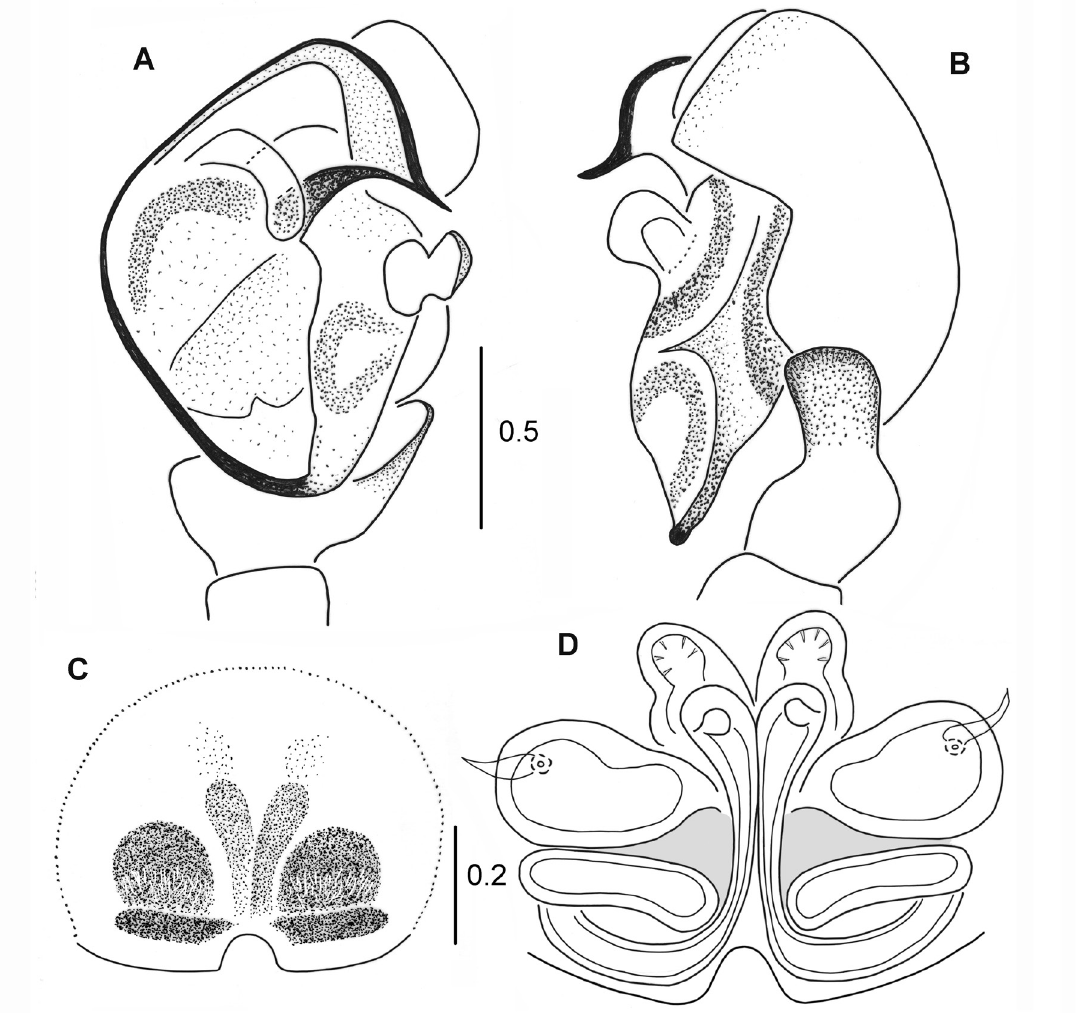
Fig. 62. Sonoita ledouxi sp. nov., paratypes, ♂♀ (MNHN). A . Palpal organ, ventral view. B . Palpal organ, lateral view. C . Epigyne. D . Internal structure of